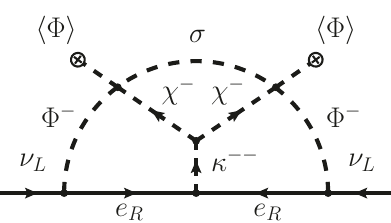
Figure 2 . Sample three loop diagram, in the mass insertion approach, contributing to the neutrino